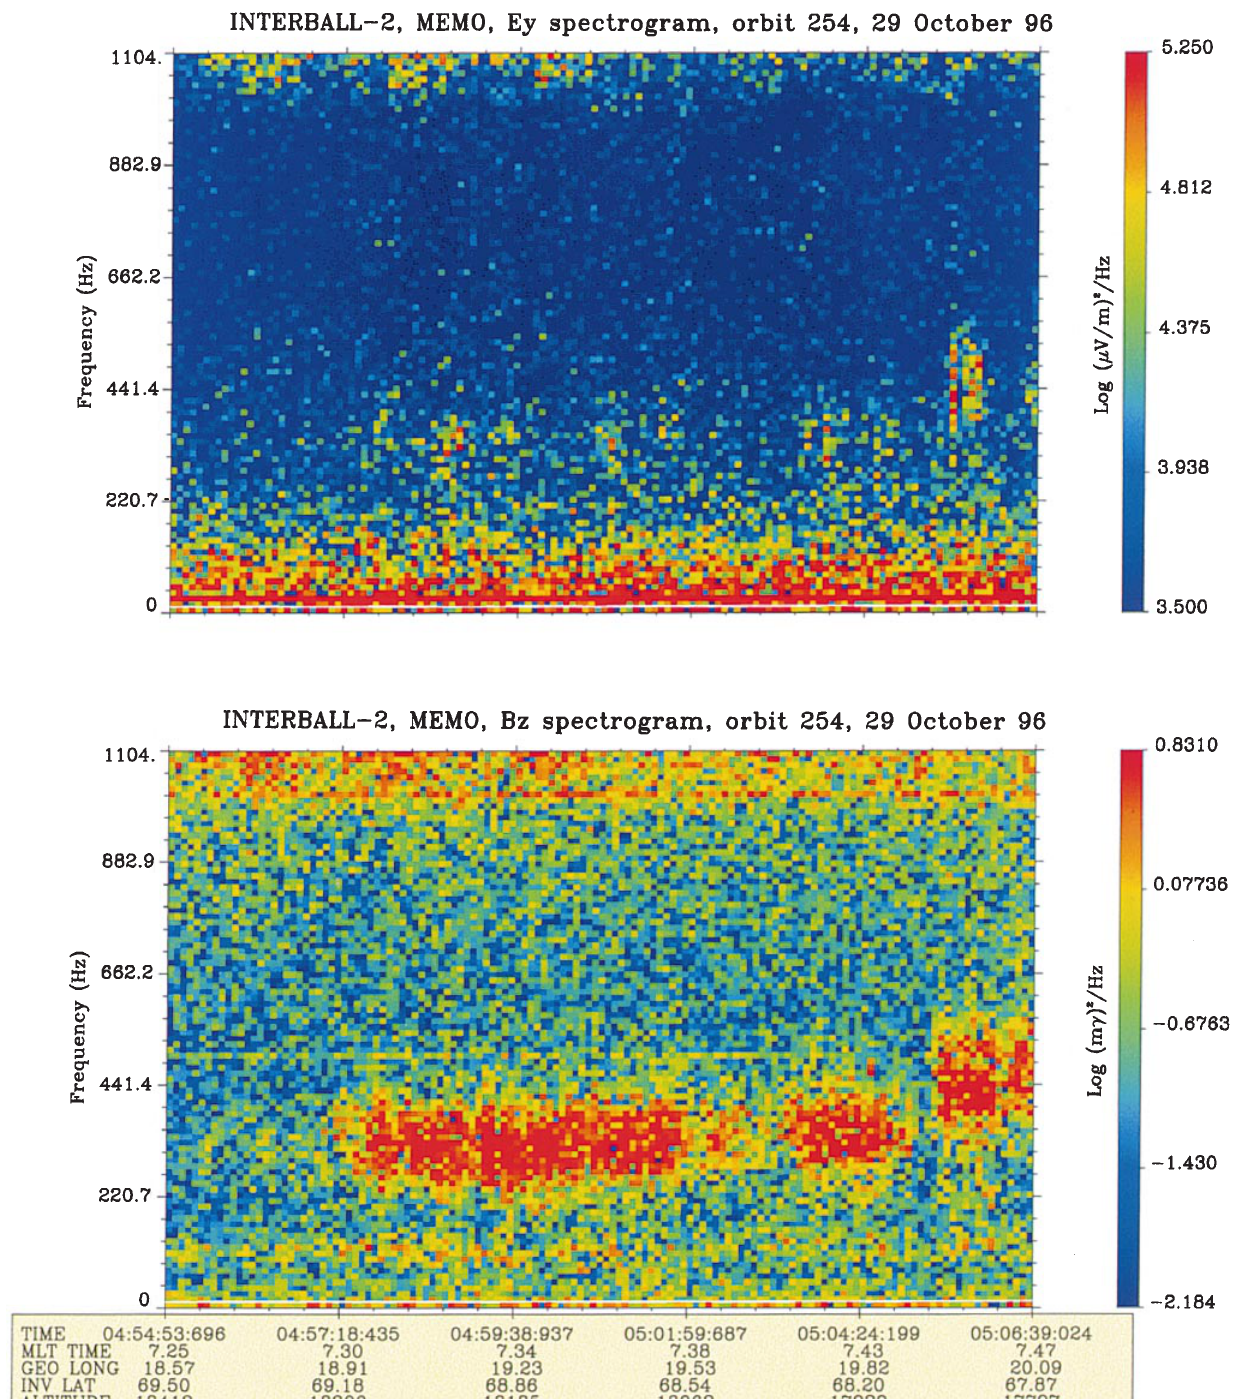
Fig. 11. Spectrogram of the Ey and Bx component for a dayside burst of ELF